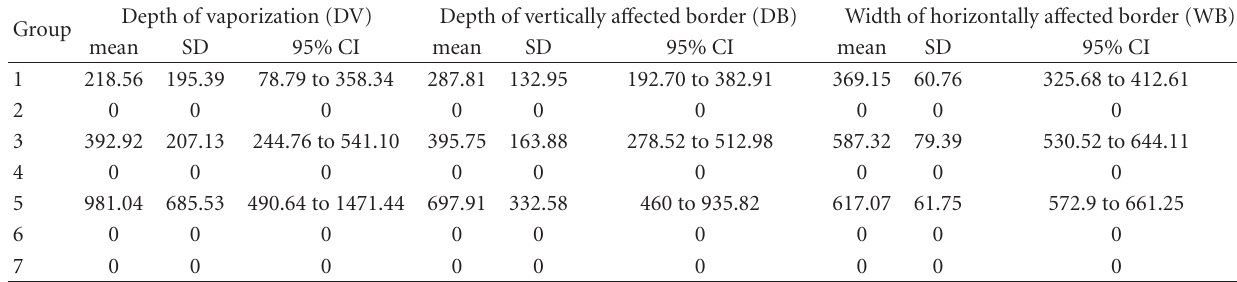
Table 2: The histologically a ff ected borders by the groups.